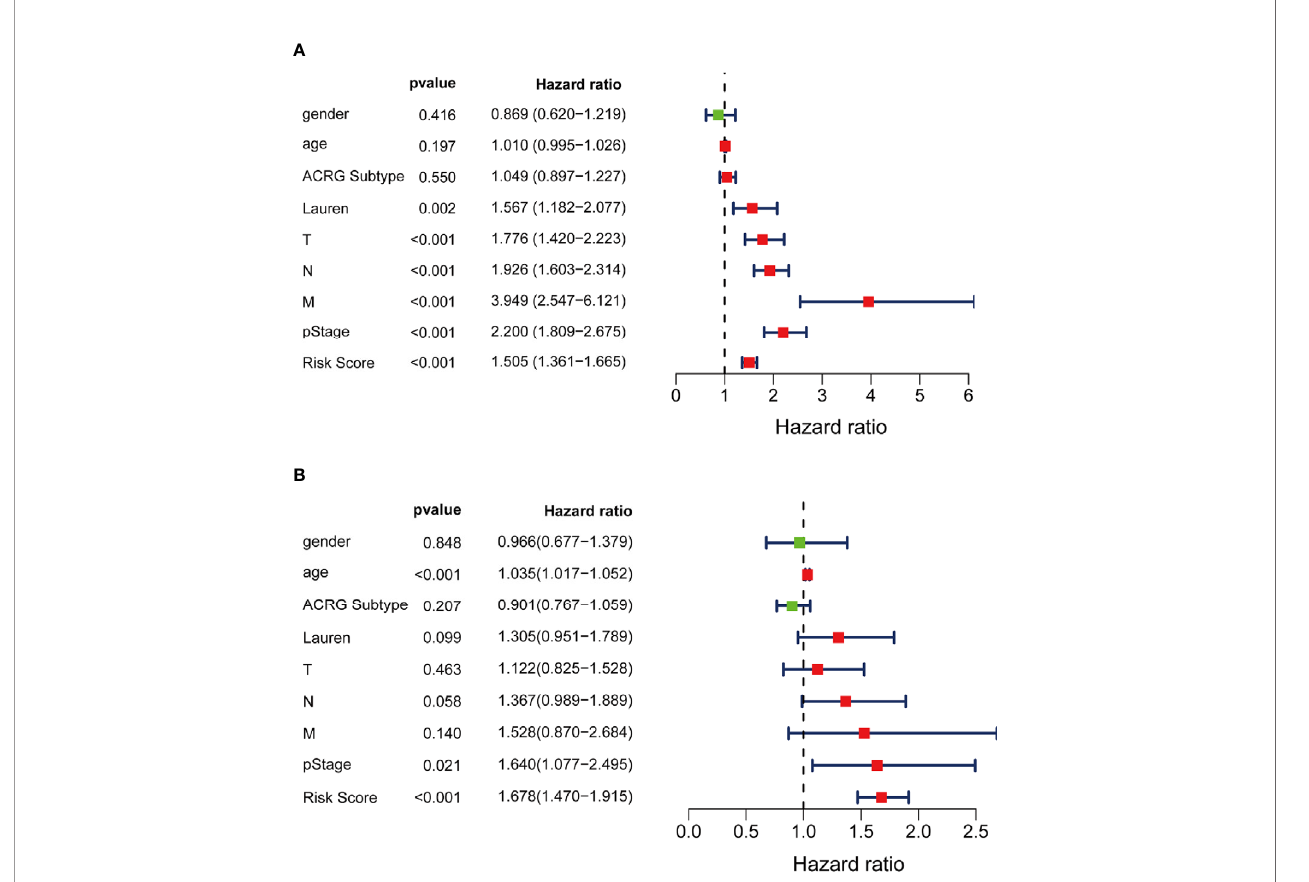
FIGURE 8 | Independent prognosis effect of Risk Score model. (A) univariate Cox regression analysis; (B) multivariate Cox regression